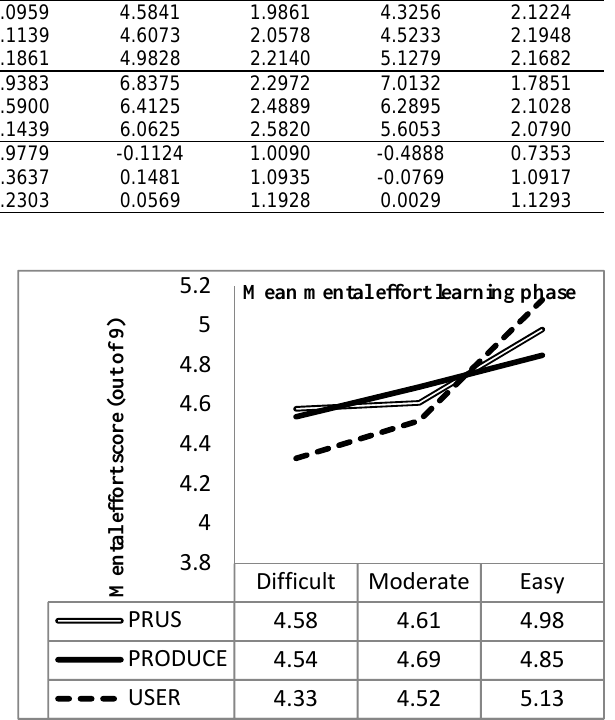
Figure 3. Group comparison of mean mental effort during learning